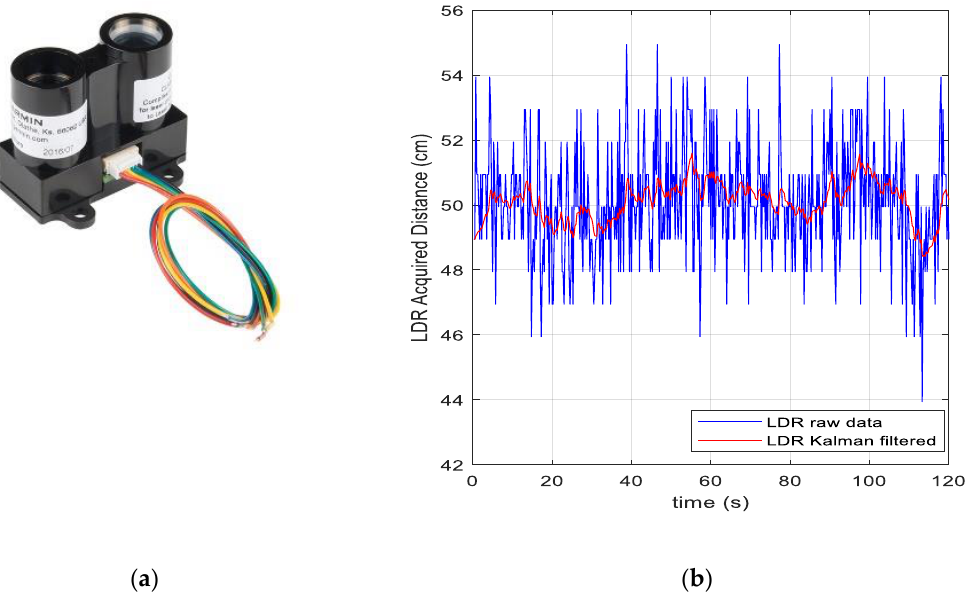
Figure 3. ( a ) Garmin LiDAR-Lite v3 (size 20 × 48 × 40 mm, weight 22 g). ( b ) Example of distance measurement in static conditions (nominal distance between sensor and obstacle: 50 cm).